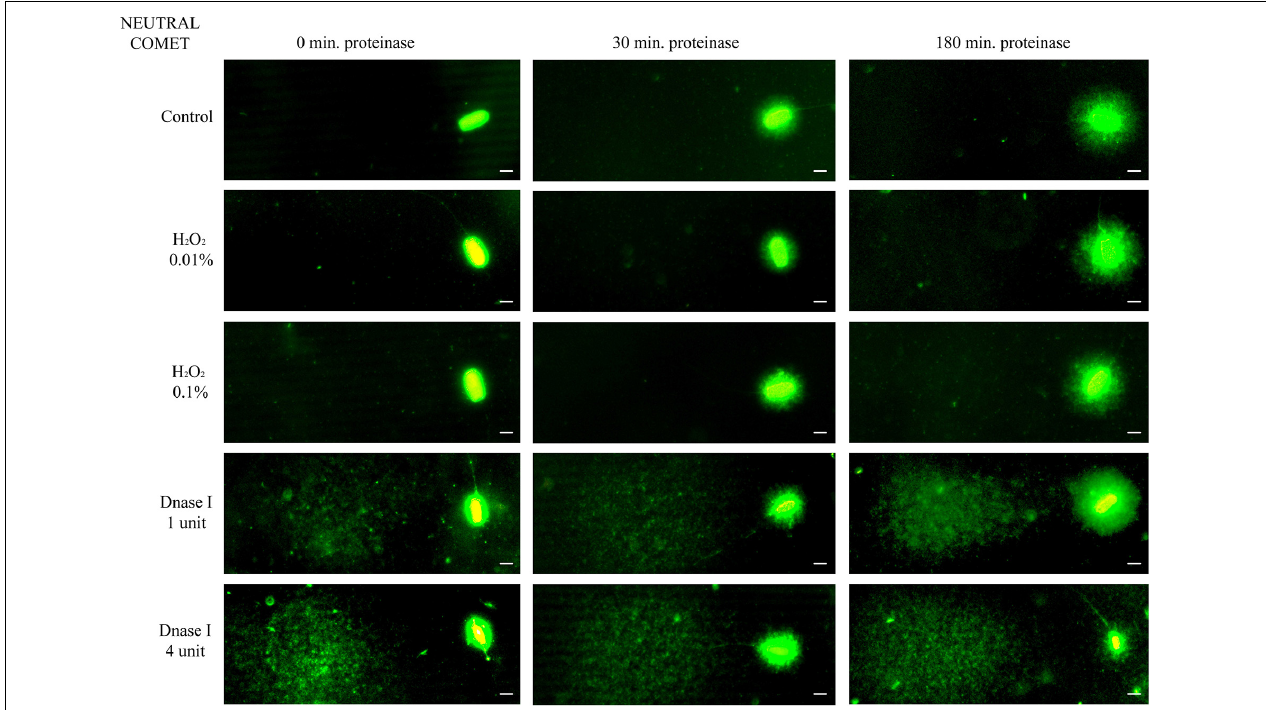
FIGURE 1 | Representative images of the neutral Comet after incubation with the additional lysis solution containing proteinase K (columns) for different times and after treating samples with H 2 O 2 and DNAse I (rows). Scale bar: 5 µ m.